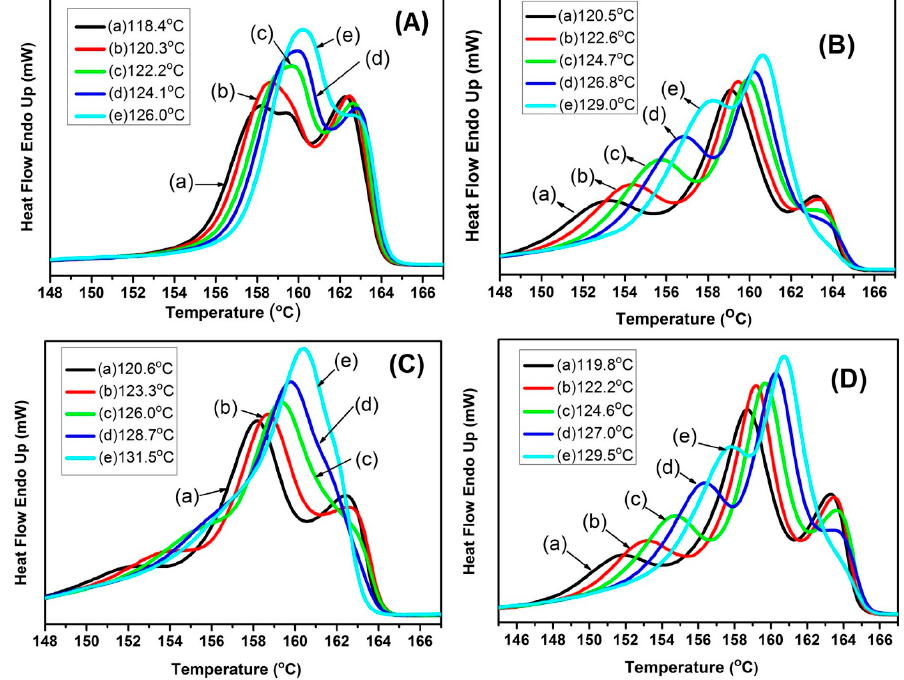
Figure 9. The DSC diagram of PLLA-PEG200 copolymer with adding different amounts of o-MMT. These DSC melting curves resulted from twice-heating under different temperatures, proceeding with isothermal crystallization (a) T 1 (b) T 2 (c) T 3 (d) T 4 (e) T 5 . The amount of o-MMT was ( A ) 0%, ( B ) 0.5%, ( C ) 1.0%, and ( D ) 1.5%, respectively.